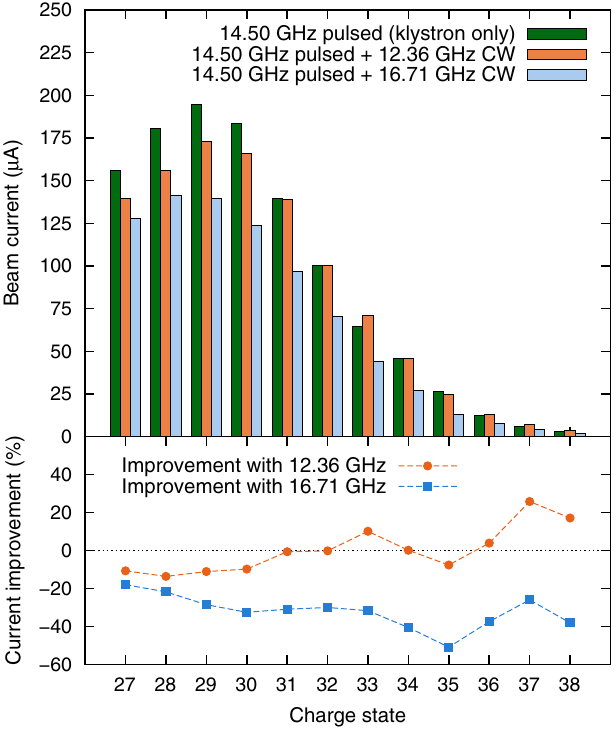
FIG. 8. Lead charge state distributions measured during after- glow with pulsed main frequency mixed with a secondary frequency operated in CW mode. Primary frequency operated at 1920 Wand the secondary at 200 W. Three cases are presented, (1) pulsed primary frequency only at 14.50 GHz, (2) pulsed primary at 14.50 GHz with 12.36 GHz secondary in CW, and (3) pulsed primary at 14.50 GHz with 16.71 GHz secondary in CW. In addition the change in the beam currents of different charge states with added secondary frequency is presented (points connected with dashed